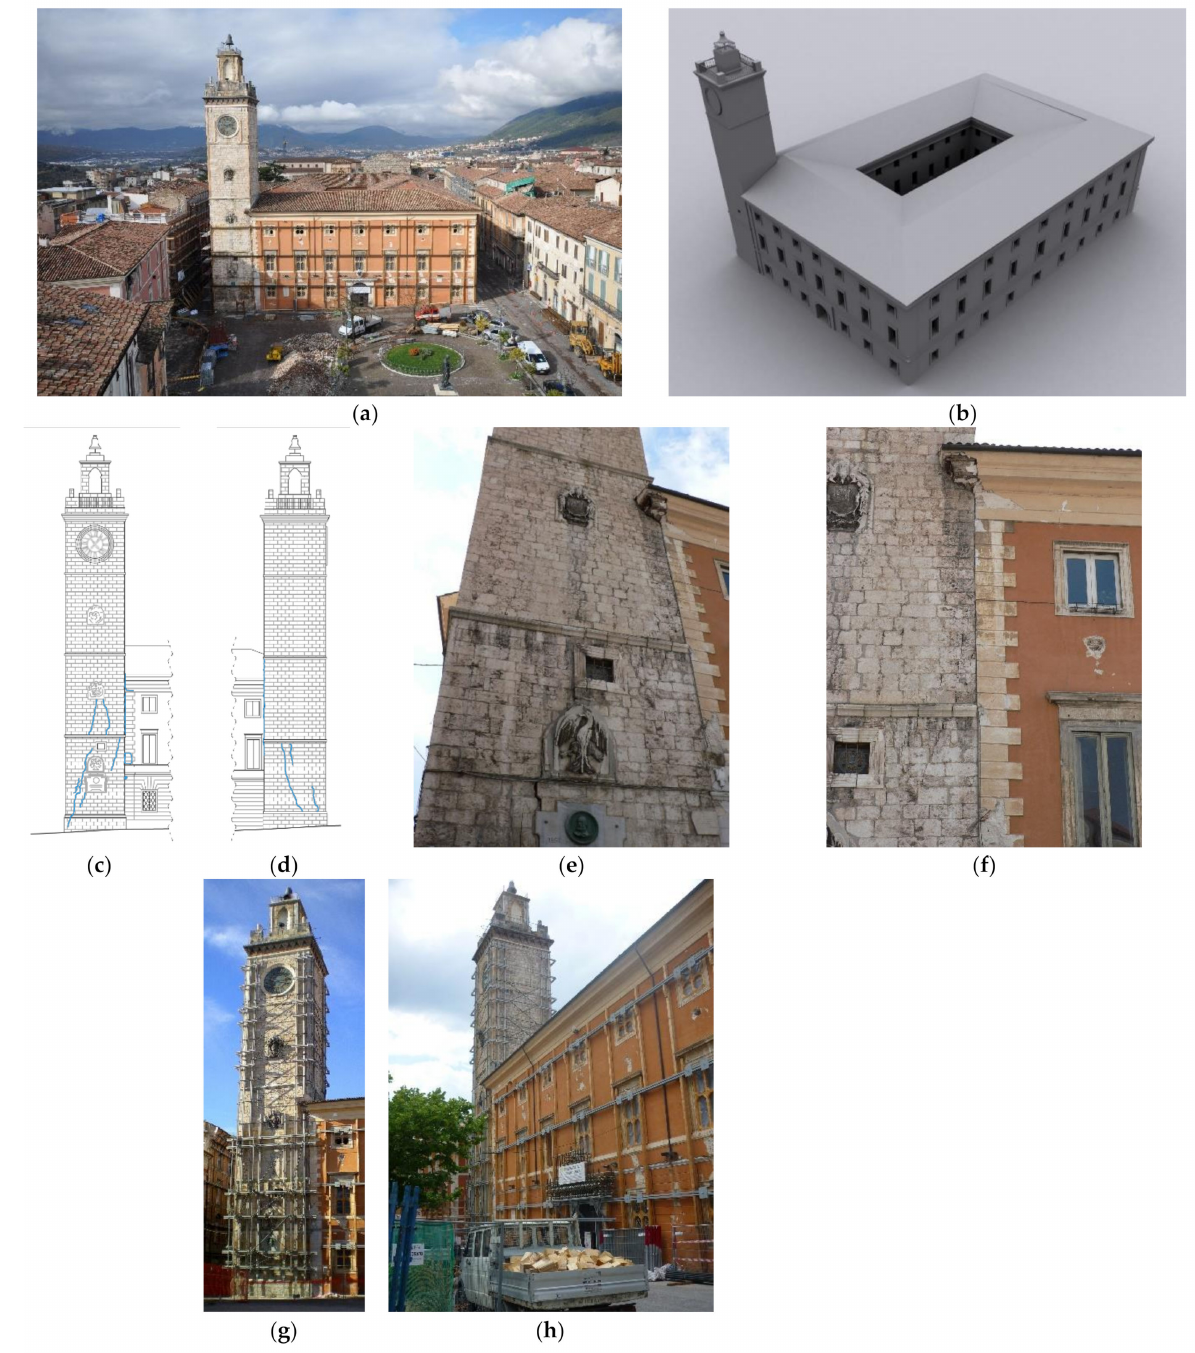
Figure 3. The structure of Palazzo Margherita ( a ) and the Civic Tower; 3D model ( b ). Crack pattern survey on the south ( c ) and east ( d ) side. Crack detected at the interface between the tower and the palace ( e , f ). Provisional interventions after the earthquake on the tower ( g ) and the palace ( h